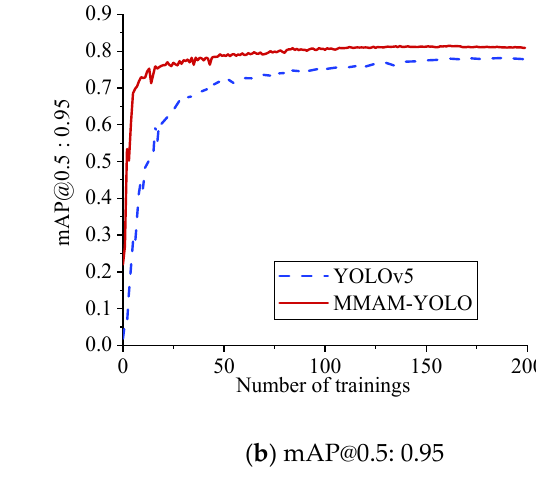
Figure 9. Comparison of training accuracy curves.